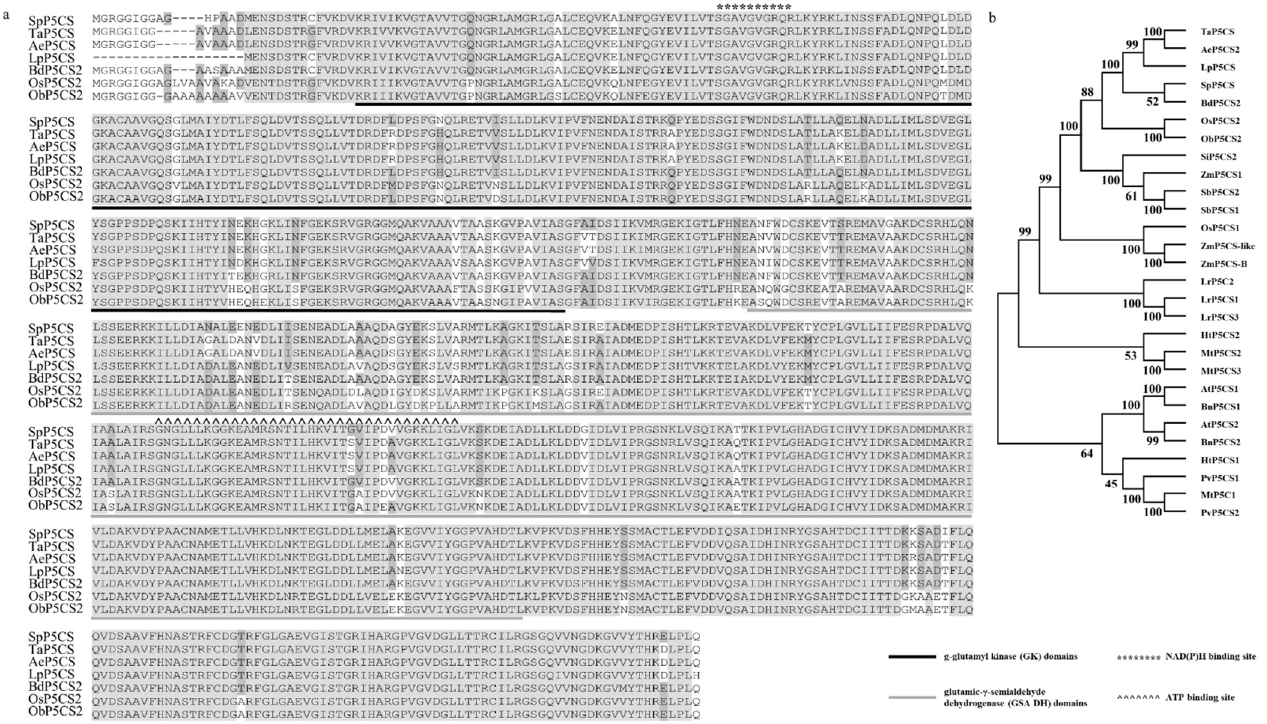
Figure 1. Sequences analysis of SpP5CS . ( a ) Multiple sequence alignment of SpP5CS and homologous proteins from other species. Legend shows the γ -glutamyl kinase (GK; 30–275 bp) and glutamic- γ -semialdehyde dehydrogenase (GSA DH; 299–600 bp) domains; ( b ) A phylogenetic tree constructed using SpP5CS and P5CS proteins from other plant species.